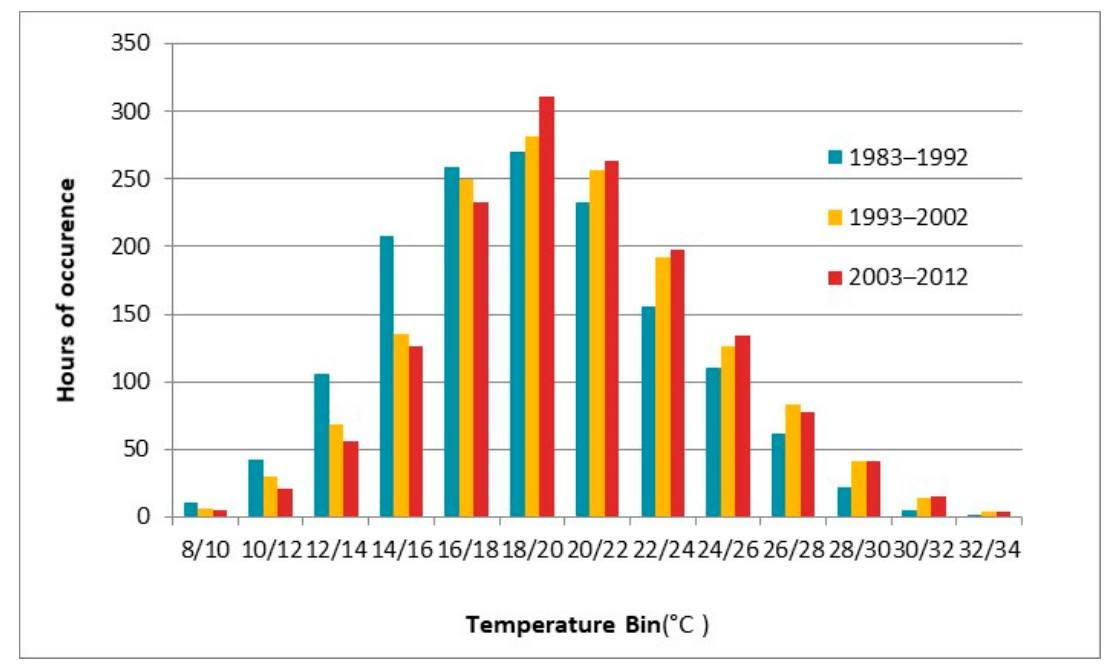
Figure 4. Temperature bin hours of occurrence in 2 °C intervals. Athens (NOA) (transitional months—October and May).